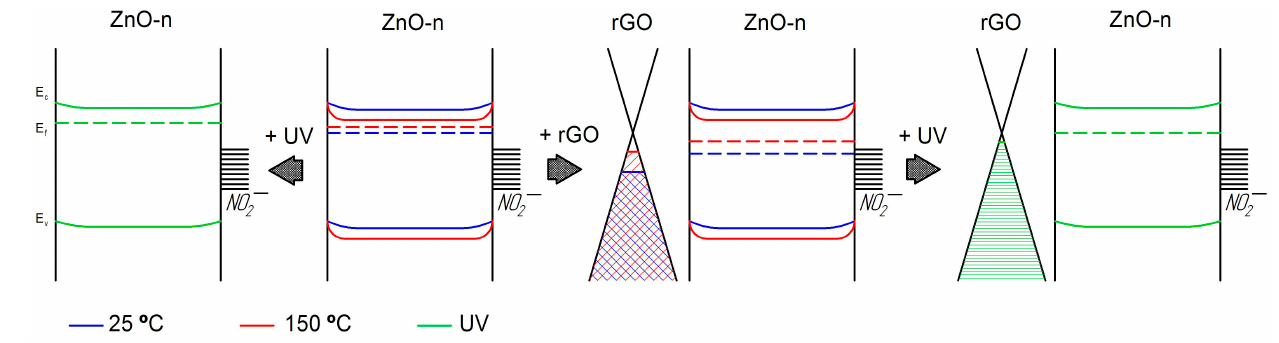
Figure 9. Scheme of ZnO band bending and ZnO/rGO heterojunction depending on temperature and UV illumination.